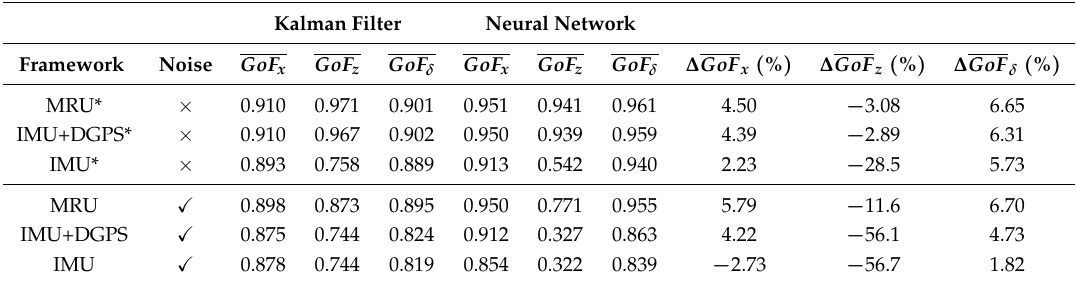
Table 6. GoF and ∆ GoF results of the KF observer and NN model for each measurement frameworks. The measurements are considered with and without noise.